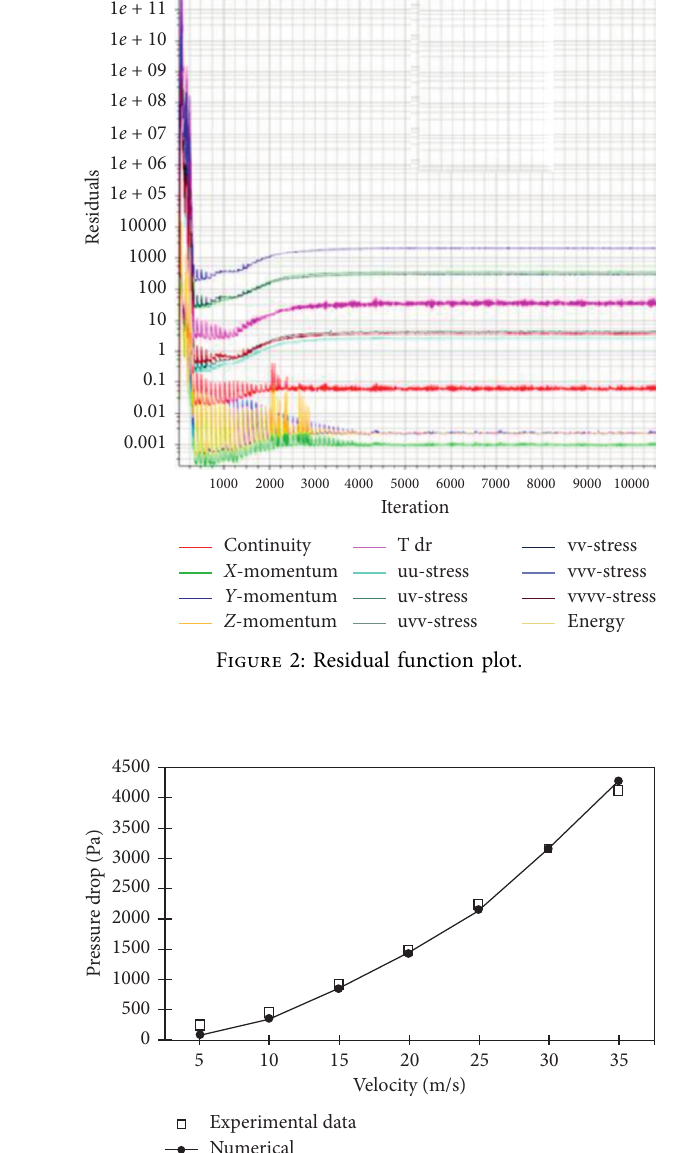
Figure 3: The computed pressure drops compared to the experimental measurements at different inlet